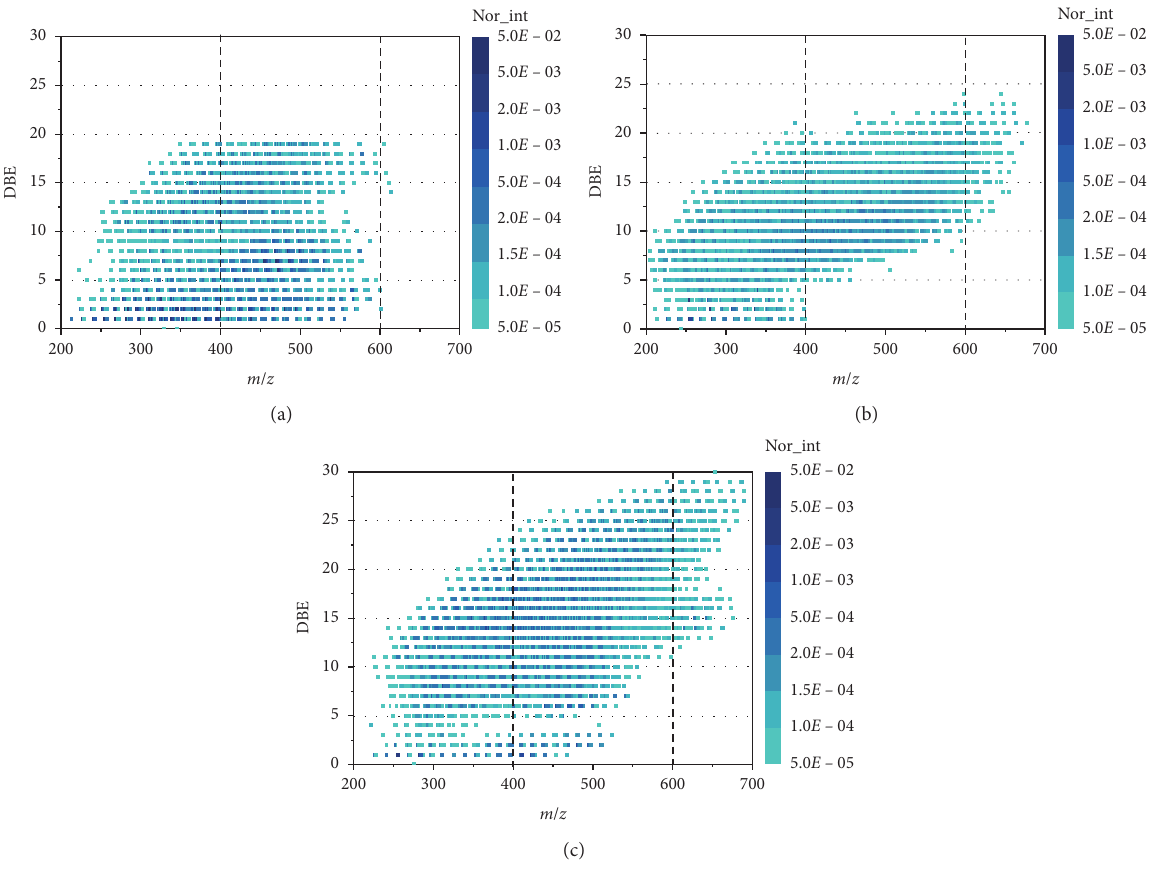
Figure 2: Respective DBE- m / z diagrams from (a) humic acids from Jiufeng forest soil, (b) humic acids from Suwannee River, and (c) humic acids from leonardite. Nor_int is the normalization of the intensity of each molecule.